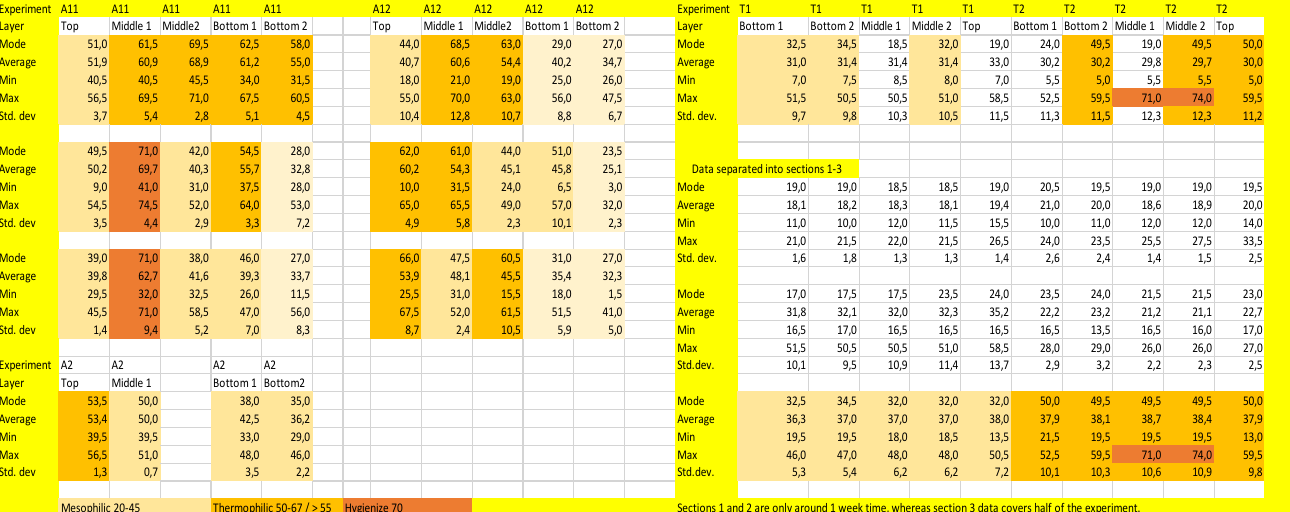
Figure A1. Composting experiments measured temperature data is presenting result from tunnel (T1 and T2), one-month windrow composting (A11 and A12) and last month data from four-month windrow composting (A2) experiments. Temperature data has been divided into sections between turn-arounds from which mode, average, minimum and maximum temperature and standard deviation has been reviewed. Color-coding has used for highlighting mesophilic, thermophilic and hygienization conditions.